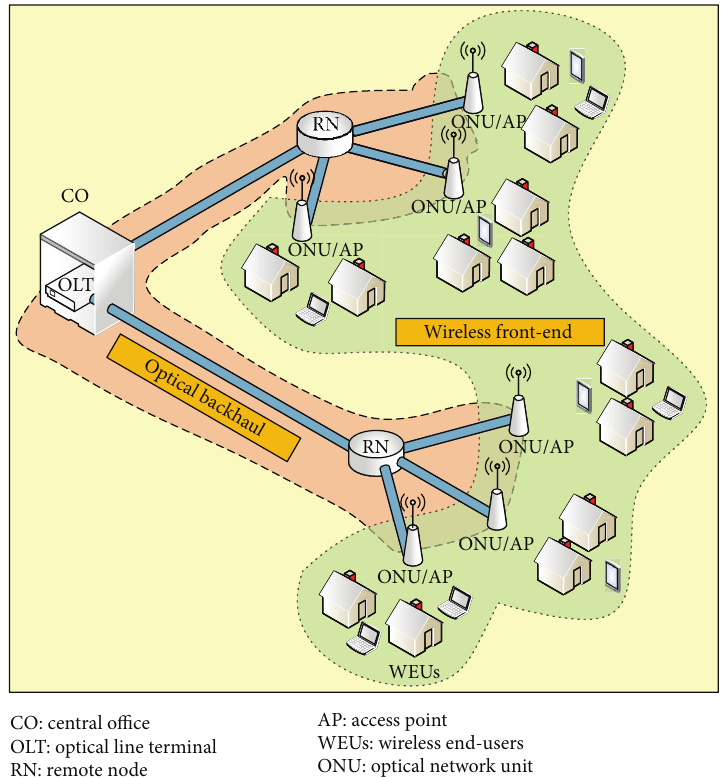
Figure 1: FiWi access network